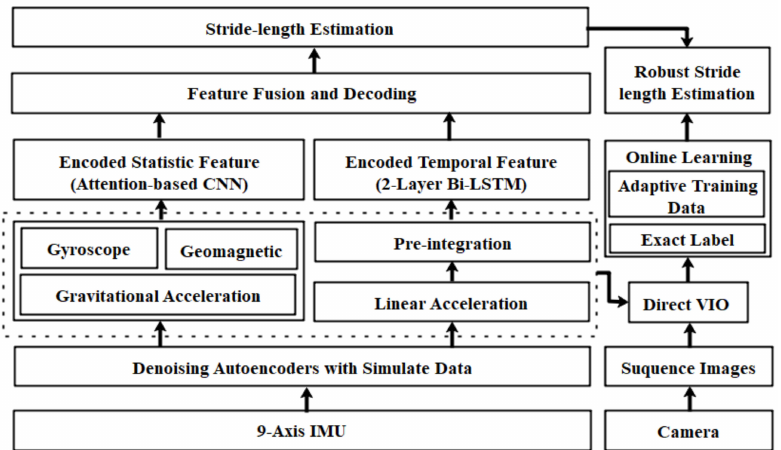
Figure 2. The system architecture of the efficient learning-based stride-length estimation